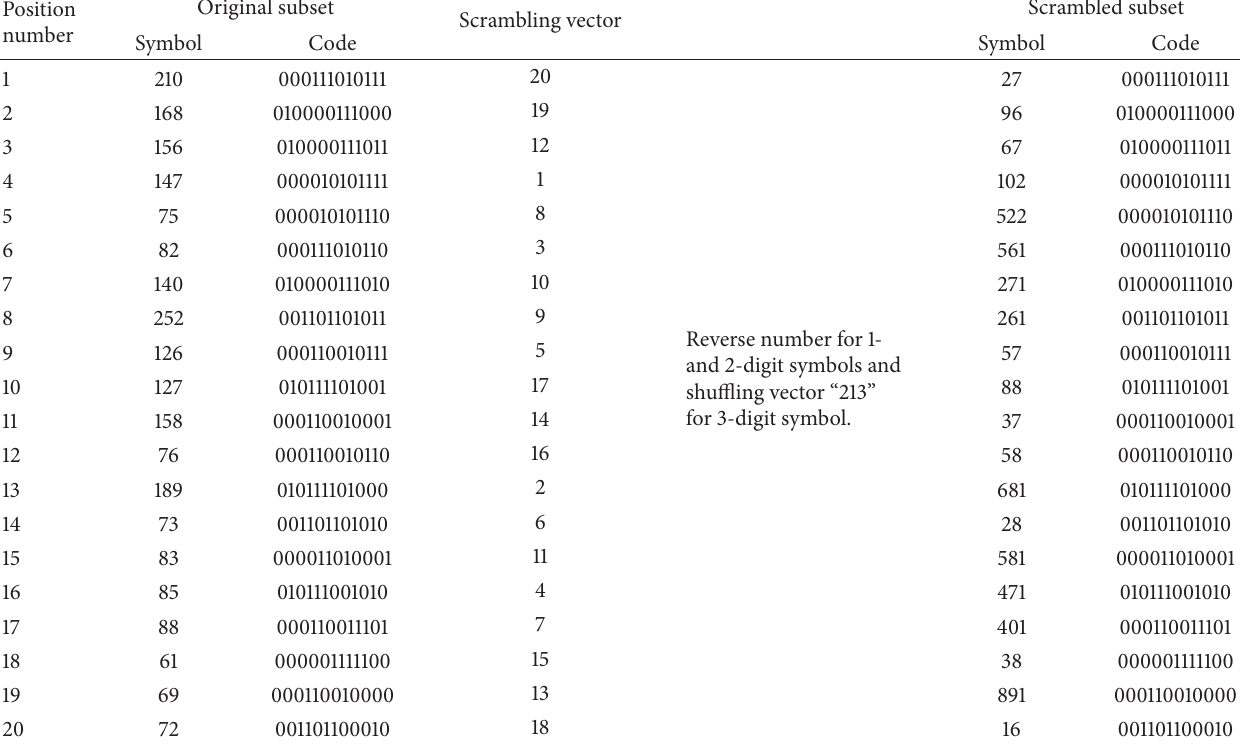
Table 1: Dictionary scrambling